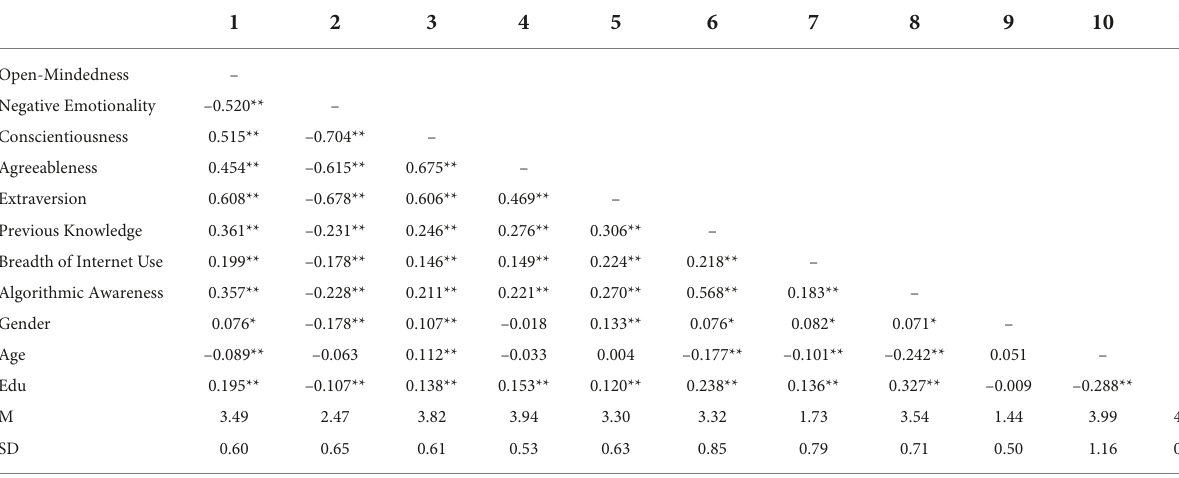
TABLE 2 Descriptive statistics and correlation analyses for each research